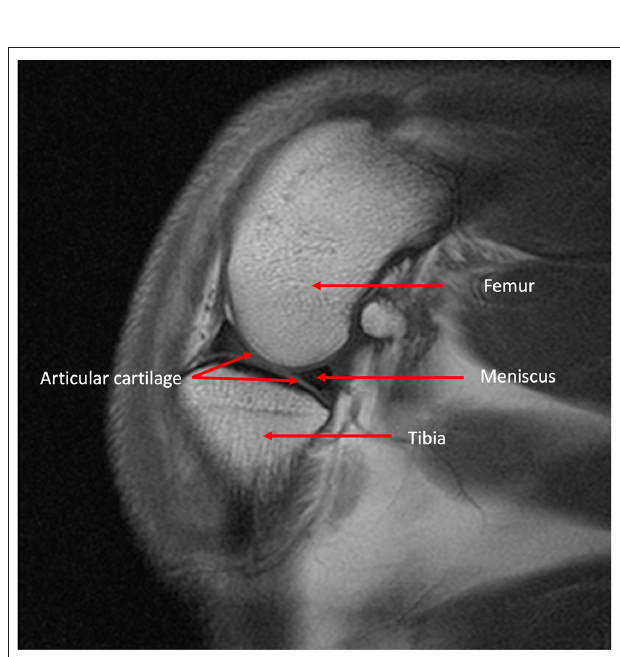
FIGURE 7 | MRI T1 weighted sagittal image of a canine stifle identifying both bone and soft tissue anatomy.